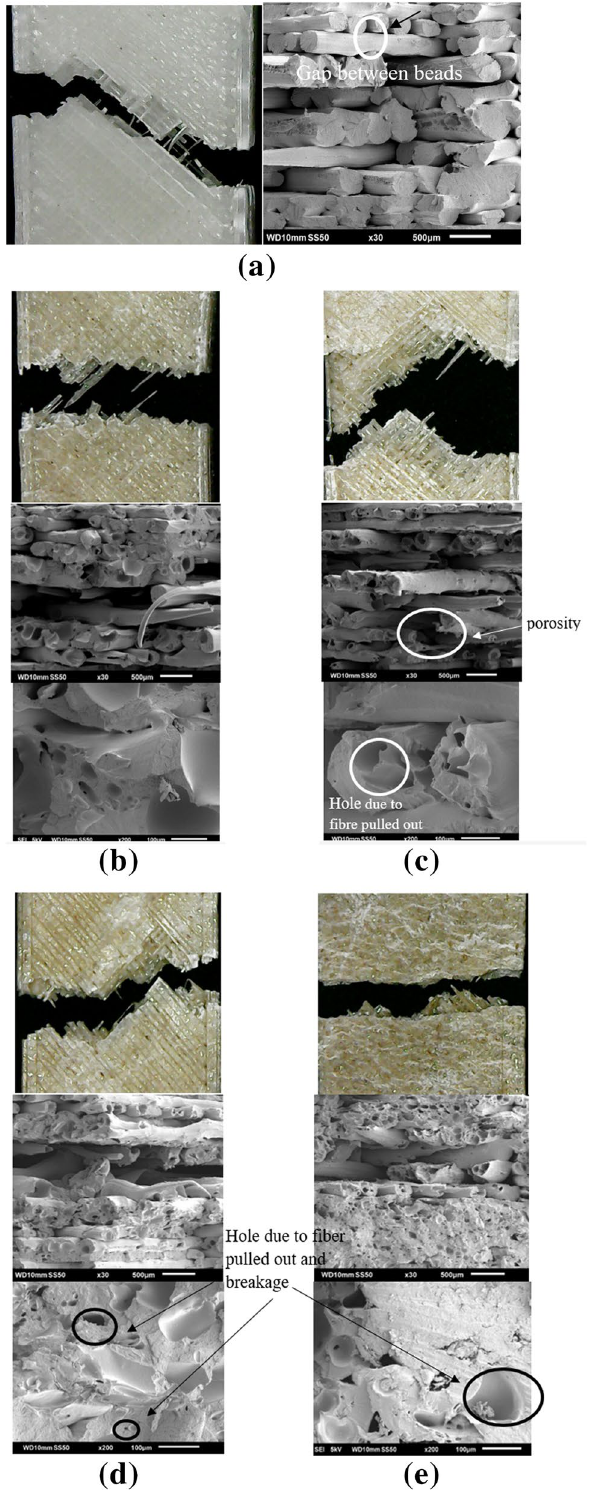
Fig. 5 Visual picture and SEM for tensile test ( a ) 0% kenaf–ABS ( b ) 2.5% kenaf–ABS ( c ) 5% kenaf–ABS. Visual picture and SEM for tensile test ( d ) 7.5% kenaf–ABS ( e ) 10%